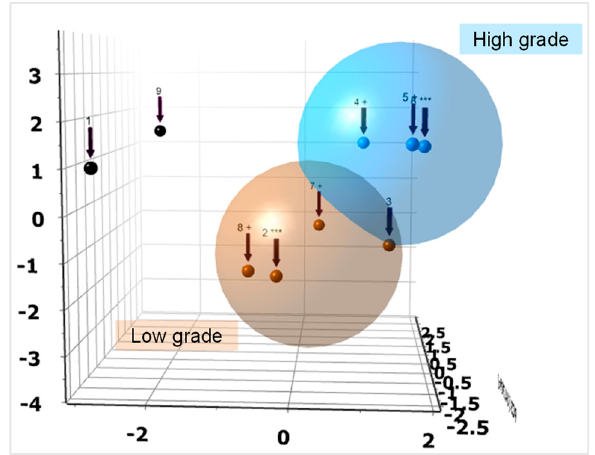
Figure 35. PCA (principal component analysis) plot with two different cluster of lithium ores representing different ore grades ( n = 9), *** indicates the most representative scan of a cluster, + indicates the two most different scans within one cluster.